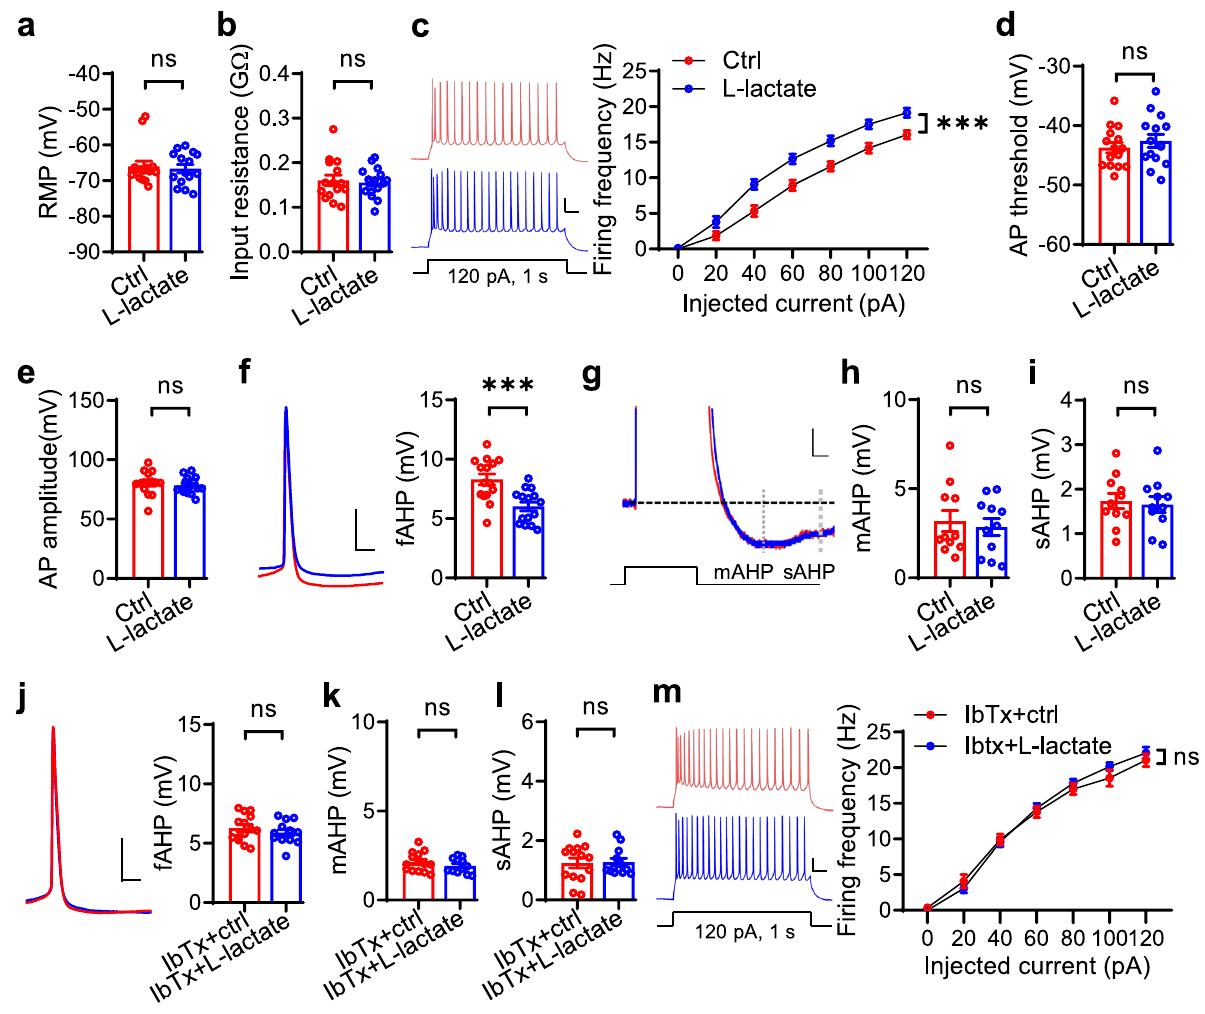
n =11 neurons from 4 male mice per group. Student ’ s t -test, for mAHP, t (20) =0.4404, p =0.6644; for sAHP, Student ’ s t -test, t (20) =0.313, p =0.7575. j – l Diminished effect of L-lactate on fAHP ( j ), mAHP ( k ) and sAHP ( l ) by IbTx pretreatment.Left,representative fi ringtraces.Scalebars:10s,20mV. n =14and12 neurons from 5 mice per group. Student ’ s t -test, for fAHP, t (24) =0.903, p =0.3755; formAHP,t (24) =1.089, p =0.287;forsAHP,t (24) =0.1261, p =0.9007. m Diminished effects of L-lactate on neuronal excitability by IbTx pretreatment. Left, repre- sentative fi ringtraces.Scalebars:0.1s,20mV.Right,quantitativedata. n =14and12 neurons from 5 mice per group. Two-way ANOVA, gene effect, F (1168) =0.6741, p =0.4128. Data were shown as mean±SEM. *** p <0.001; ns, no signi fi cant differ- ence. Source data are provided as a Source Data fi